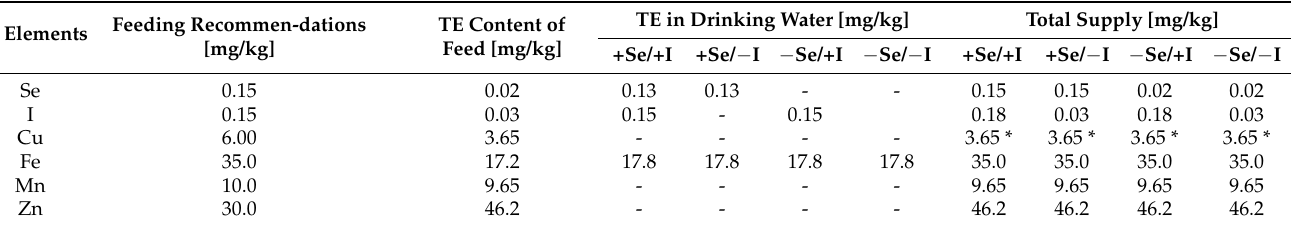
Table 1. TE supply of mice. Feeding recommendations [31] and content of the trace elements selenium (Se), iodine (I), iron (Fe), copper (Cu), manganese (Mn), and zinc (Zn) in food and water within the animal experiment. Feed contents were determined by ICP-MS/MS. * supplied concentration below recommendation, but substantially above a concentration that triggers a